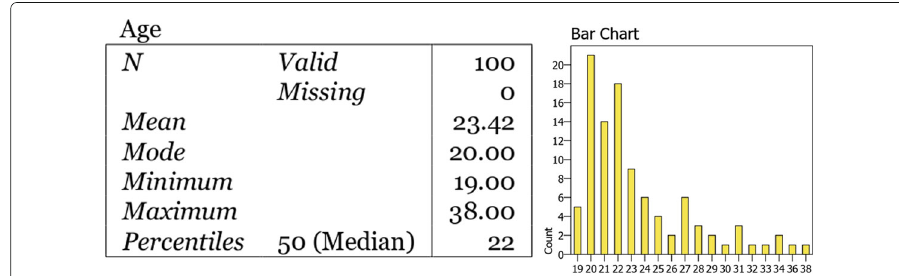
of 3D objects or their ability to remain oriented in 3D (real or virtual)